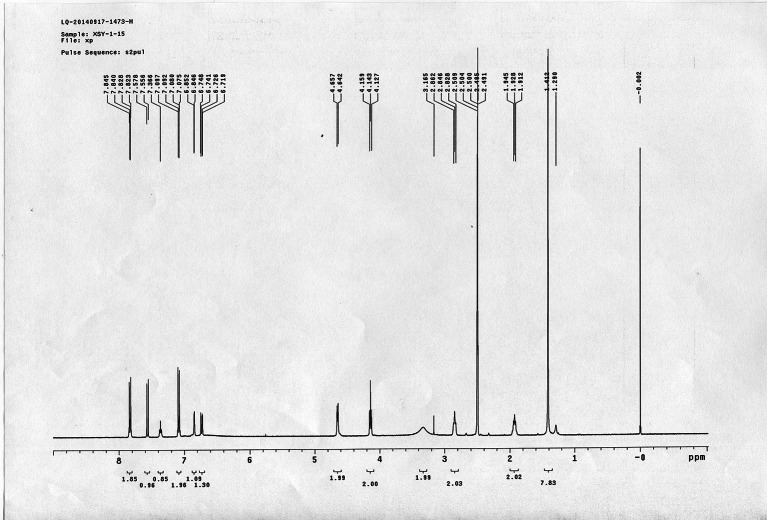
1H NMR spectra of compound 23.